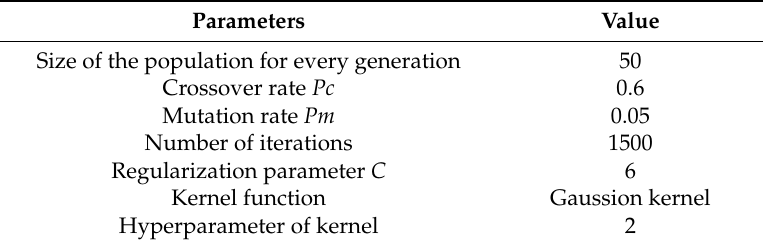
Table 4. Input parameters in the proposed GA – KELM-based algorithm.